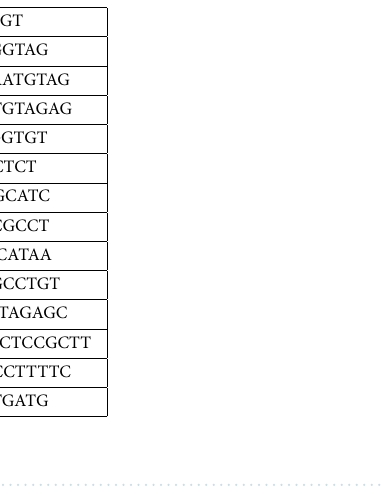
RNA isolation and real‑time PCR.